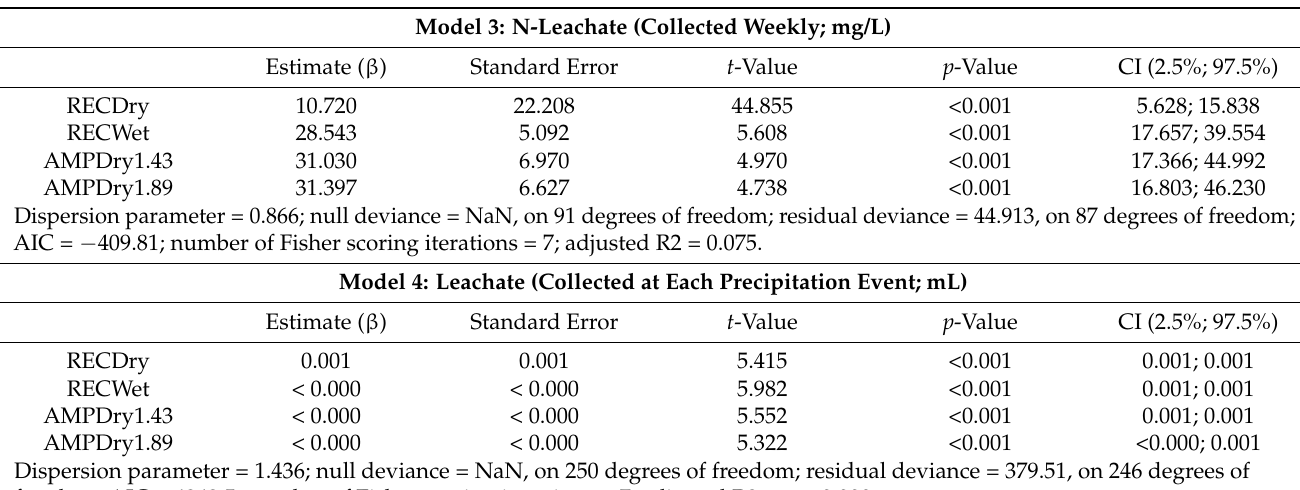
Figure 3. Seasonal differences in total leachate (mL) collected and concentration of N-leachate (mg/L) by treatment across the experimental period. Table 3. Estimated regression parameters, standard errors, coefficients and p -values for 2 gamma